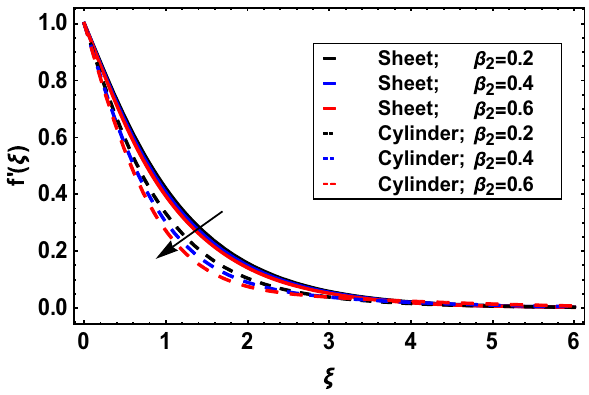
Figure 6: Change in nano fl uid velocity due to β